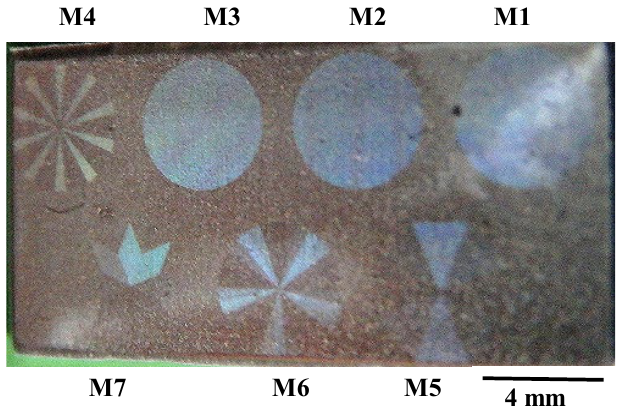
Figure 12. AA1060 pure aluminium plate with the seven micro-textures transcribed by CNC imprinting with the use of the laser-printed AISI316L die in Figures 8 and 9.